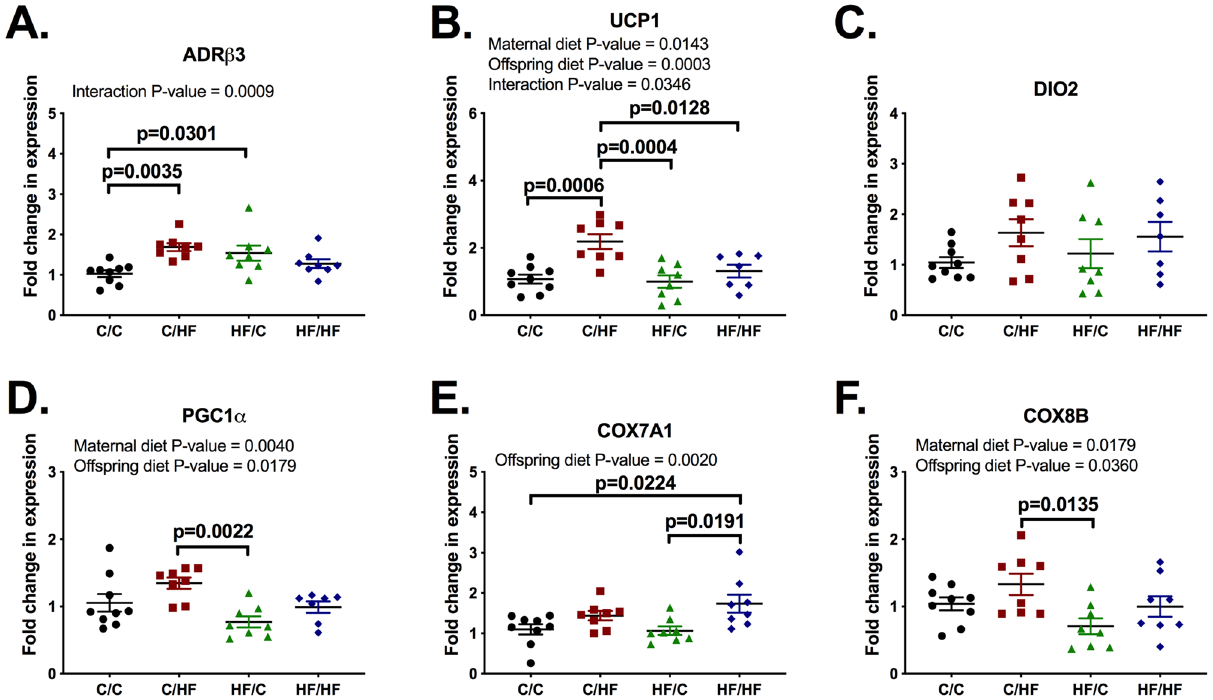
Figure 2. The mRNA levels of brown adipose tissue are affected by maternal and offspring high-fat diet in males. ADRβ3 ( A ), UCP1 ( B ), DIO2 ( C ), PGC1α ( D ), COX7A1 ( E ) and COX8B ( F ) mRNA were quantified in brown adipose tissue of 30-week old male offspring and fold change was determined using the 2 −∆∆ Ct method. C/C, dam and offspring fed standard laboratory diet; C/HF dam fed standard laboratory diet and offspring fed high-fat diet; HF/C dam fed high-fat diet and offspring fed standard laboratory diet; HF/HF dam and offspring fed high-fat diet. Data on graphs show mean ± SEM as well as individual points. n = 7–9 mice from 4 to 6 litters per group. Data analysed by two-way ANOVA with Tukey’s multiple comparisons test. P-values as well as the overall effects of maternal and offspring diet are reported where